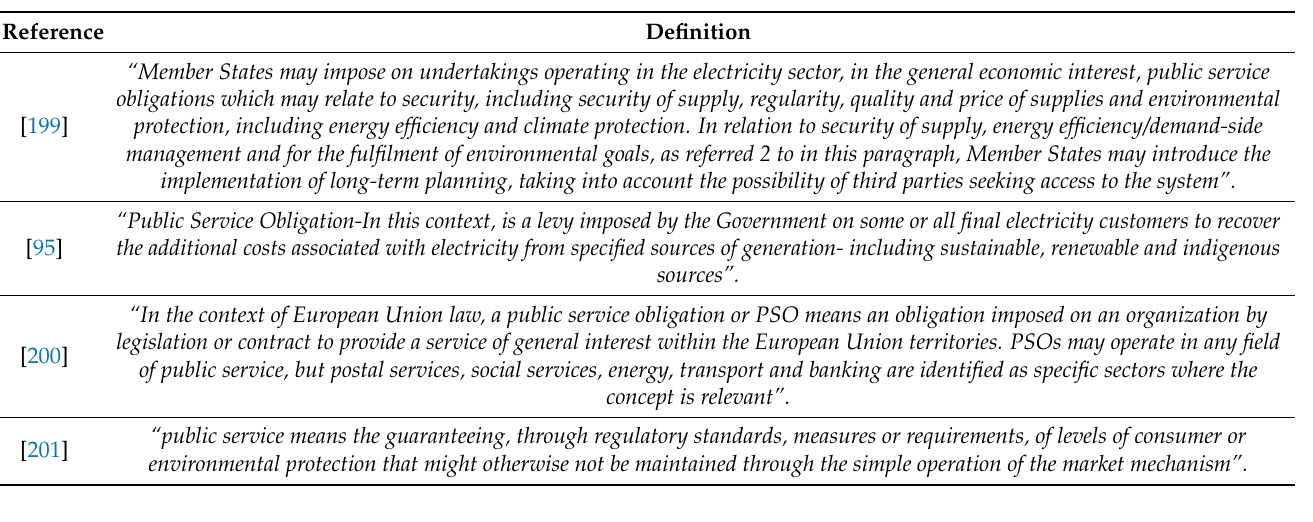
Table A1. Definitions of the public service obligation.